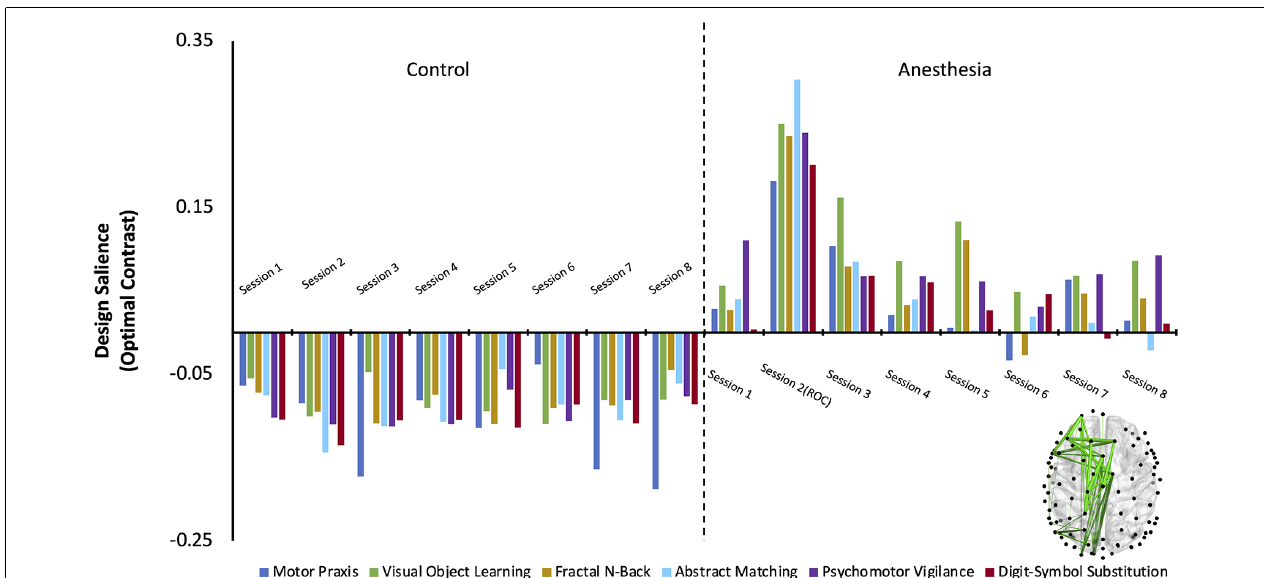
FIGURE 3 | The dominant latent variable (LV = 1) capturing the network of maximal functional connectivity covariance between groups (Control and Anesthesia) across all eight testing sessions and all six cognitive tasks (PLS analysis, variation 1). Permutation testing confirmed the statistical significance of the entire design salience ( p < 0.0005), and the attributable proportion of cross block covariance (ES) was calculated to be 87%. Connections that reliably express the contrast were identified using bootstrap ratios thresholded at 99% (see “Materials and Methods” section) and are mapped on the